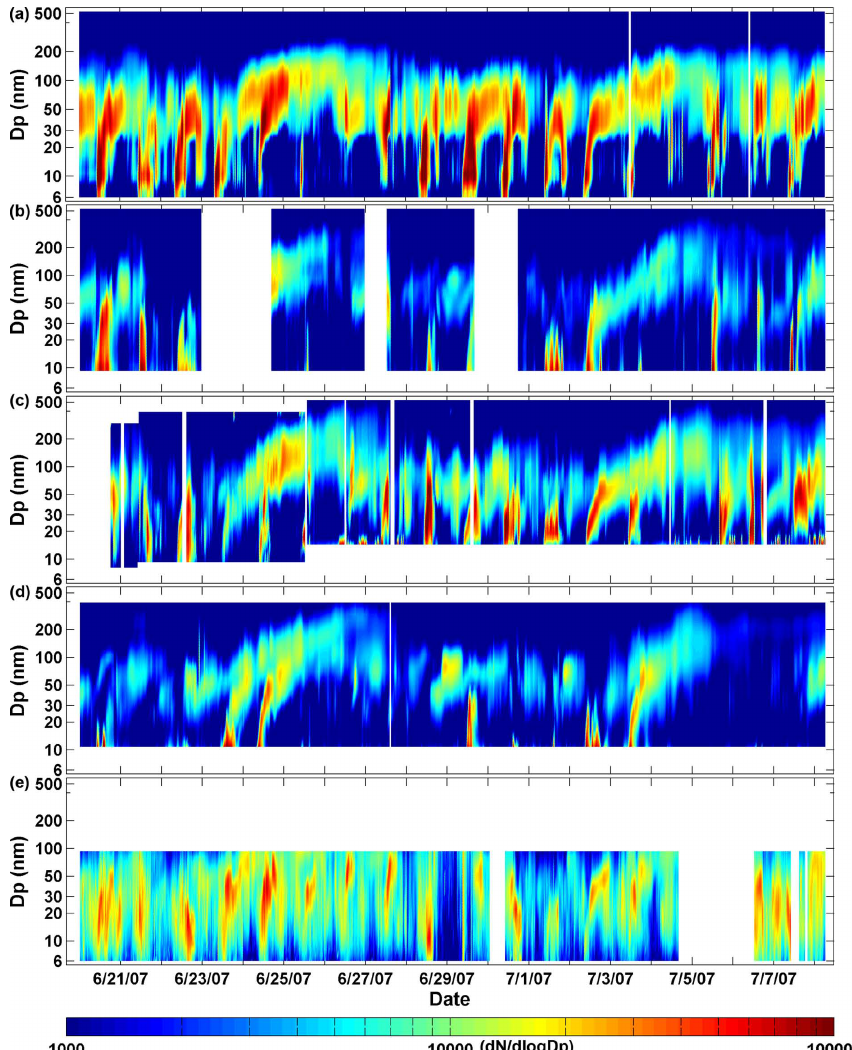
Fig. 5. Evolution of particle number and size distributions at the five sites: Harrow (a) , Ridgetown (b) , Bear Creek (c) , Egbert (d) , and Toronto (e)